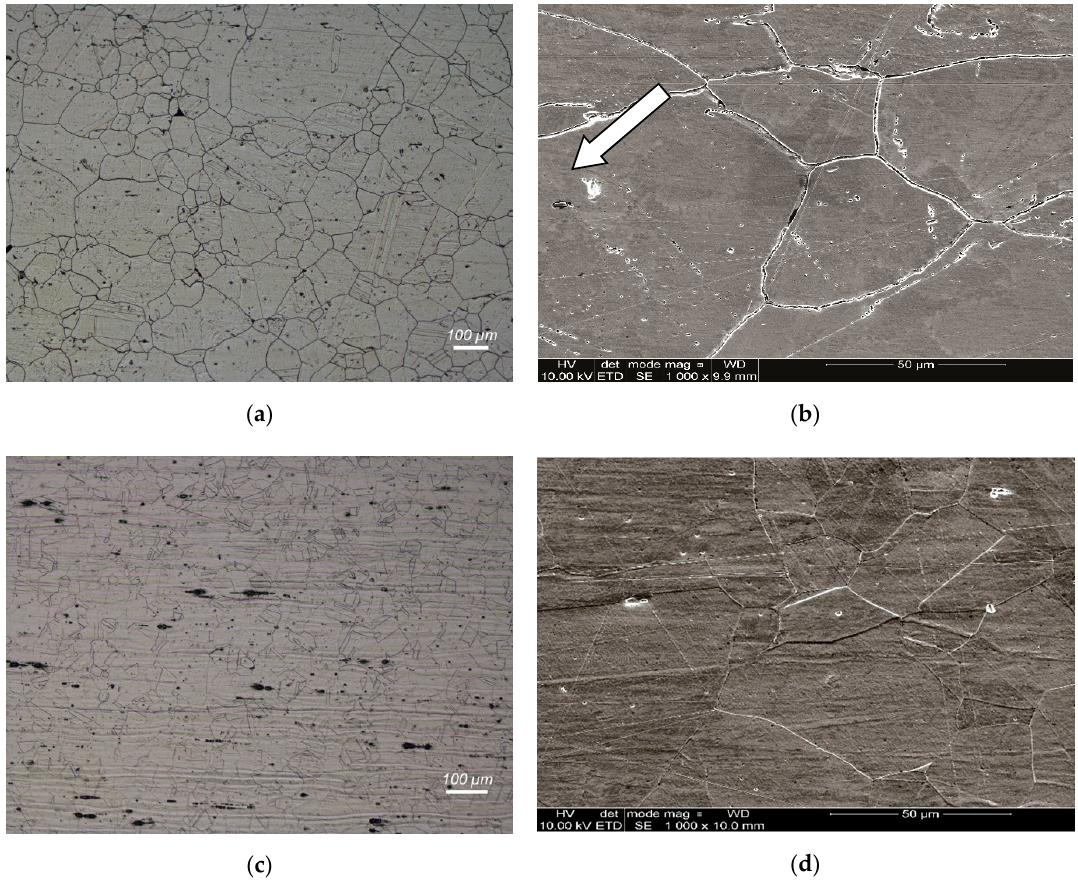
Figure 7. Metallographic structure of ( a ) Incoloy 800HT nickel alloy–optical microscopy; ( b ) Incoloy 800HT nickel alloy–electron microscopy; ( c ) 304L austenitic stainless steel–optical microscopy; ( d ) 304L austenitic stainless steel–electron microscopy.